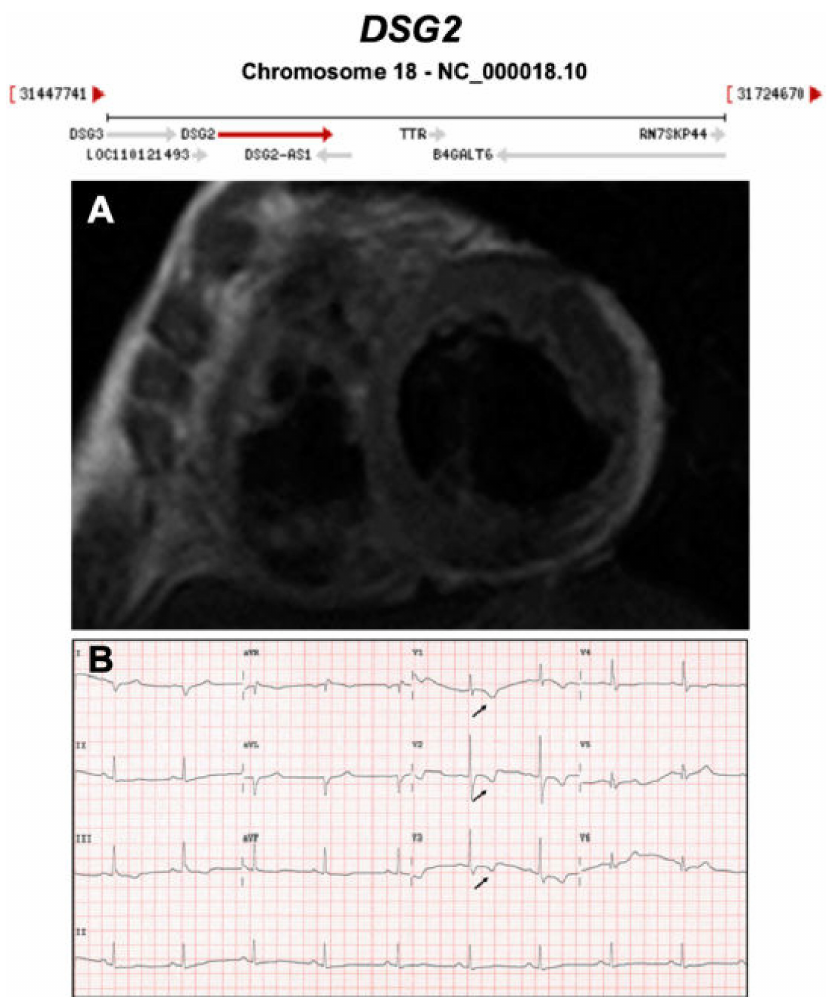
Figure 5. Exemplar MRI and ECG finding found in ACM patients with DSG2 mutations. ( A ) CMR of a patient with DSG2 p.Leu237Ter mutation showing dilation of both ventricles; ( B ) a representative ECG of the same patient showing T wave inversion in V1-V3. Reproduced with permission from Chen et al. (2020)